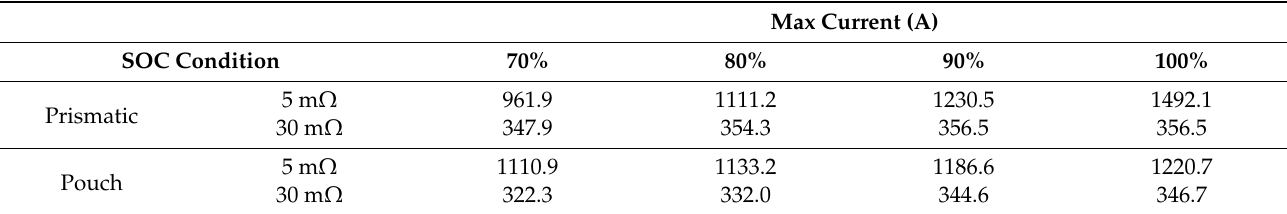
Table 3. Maximum currents during external short